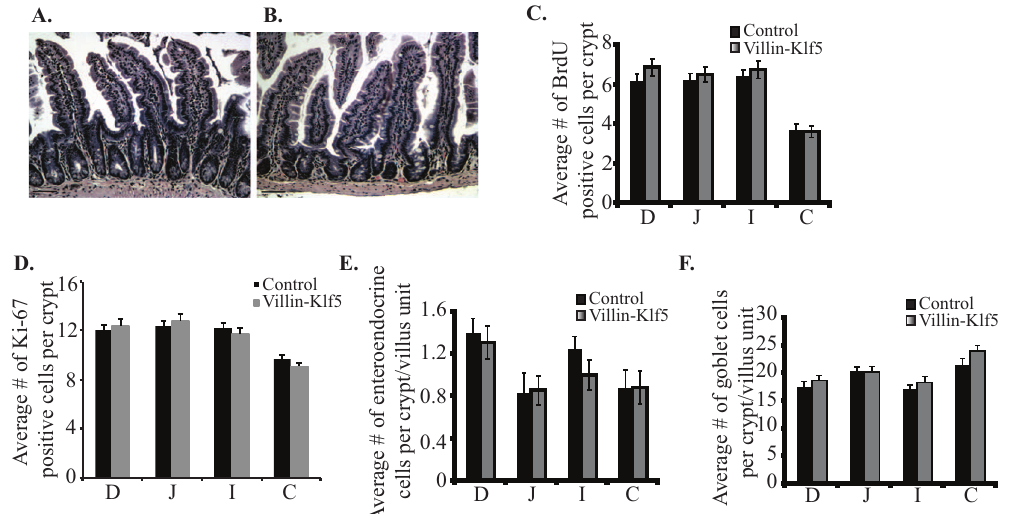
Figure 2. Villin-Klf5 transgenic mice had normal-appearing intestinal mucosa. ( A–B ) Compared with 1 year-old littermate controls ( A ), hematoxylin and eosin (H&E)-stained ileal epithelia, along with underlying lamina propria and muscular layers, appeared normal in 1 year-old Villin- Klf5 mice ( B ). Findings were similar in duodeum, jejunum, and colon of Villin-Klf5 mice. Scale bars: 50 m m. ( C–D ) Quantitation of BrdU-labeled ( C ) or Ki-67 positive ( D ) cells revealed no changes in proliferation in the small intestine or colon of Villin-Klf5 mice at 1 year of age, compared to littermate controls. ( E ) The number of chromogranin-A positive enteroendocrine cells per crypt-villus unit was unchanged between control and Villin-Klf5 mice at 1 year of age. ( F ) By Alcian blue staining, no difference was observed in the number of goblet cells within small intestine or colon of 1 year-old control and Villin-Klf5 mice. Similar results were observed for proliferation and differentiation of intestinal cell types in 1 month-, 3 month-, and 6 month-old mice. D= Duodenum, J=Jejunum, I=Ileum, C=Colon.